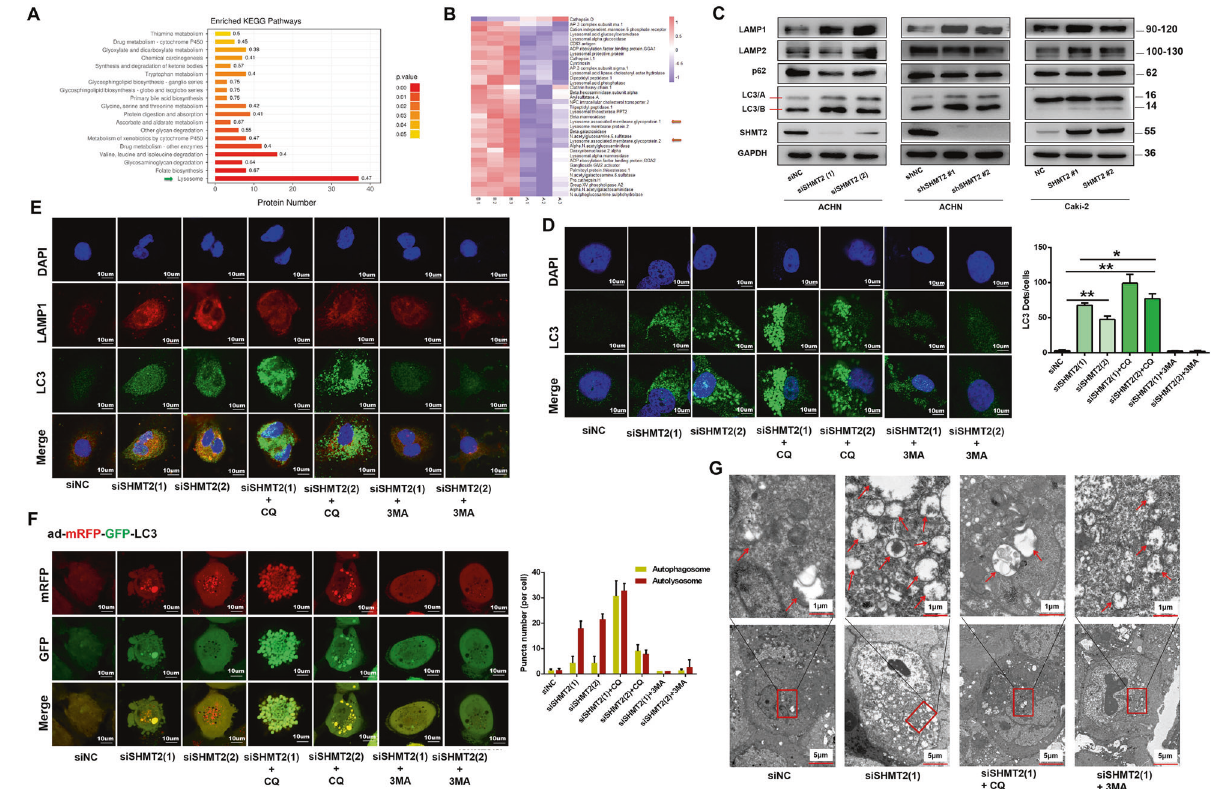
Fig. 4 SHMT2 knockdown in ccRCC cells induced the autophagy-lysosome pathway and affected autophagic fl ux. A Top enriched KEGG pathways based on the differentially expressed proteins between shSHMT2 and shNC ACHN cells. The abscissa represented the number of differentially expressed proteins in each pathway. The color of the bar chart indicated the signi fi cance of the enriched KEGG pathways. B Heat- map of 37 differentially expressed proteins involved in the lysosome pathway. Red represented signi fi cantly upregulated proteins and blue represented signi fi cantly downregulated proteins after SHMT2 knockdown. Red arrows indicated the LAMP1 and LAMP2. A represented shNC, and B represented shSHMT2. C The levels of autophagy-lysosome-related proteins after knockdown or overexpression of SHMT2 in ccRCC cells. D Immuno fl uoresence analysis of LC3 (green) in ACHN cells after SHMT2 knockdown alone or in combination with CQ (20uM) or 3-MA (5 mM) for 48 h. Nuclei were stained with DAPI. E Double immuno fl uoresence analysis of the co-localization of LC3 (green) and LAMP1 (red)